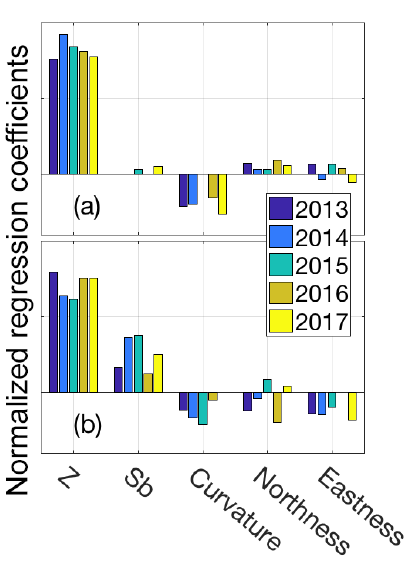
Figure 6. Terrain parameter beta coefficients for (a) Gulkana and (b) Wolverine for multivariable linear regression for each year of the study interval.